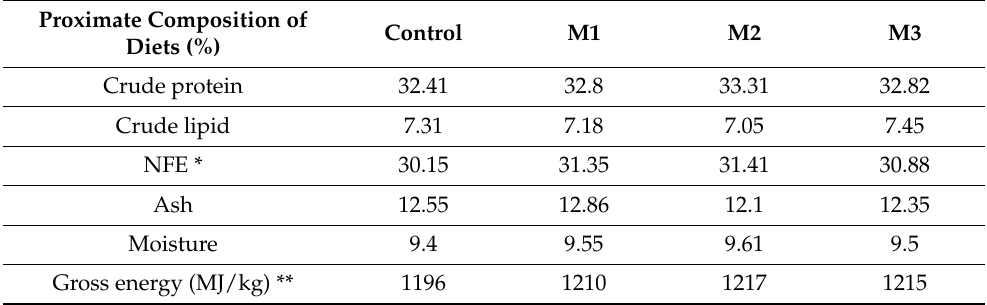
Table 1. Proximate composition of diets incorporated with zero (control), 0.5% (M1), 1% (M2), and 2% (M3) Myristica fragrans extract per kg diet. Proximate Composition of Diets